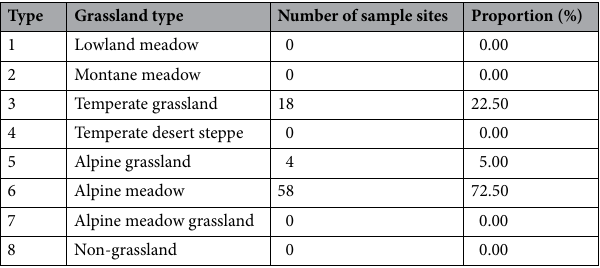
Table 2. Statistics on the number of marmot distribution sites in different grassland types.